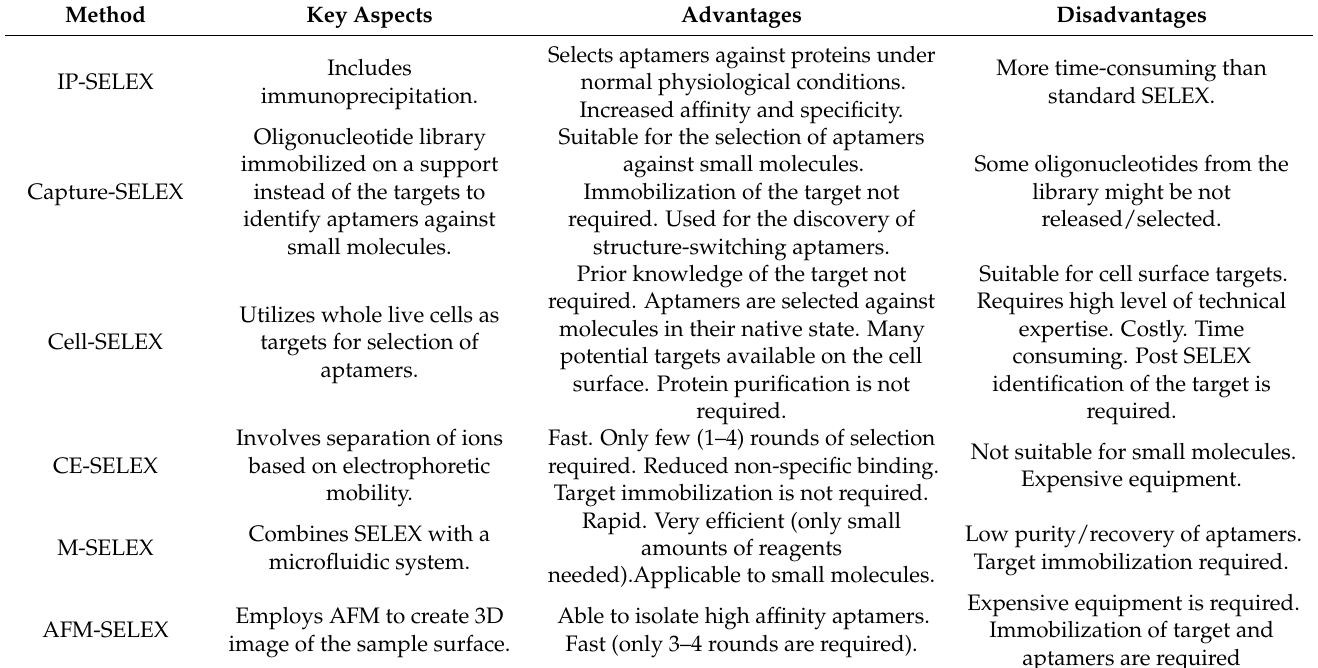
Table 2. Key aspects, advantages, and disadvantages of the currently used SELEX methods [99].